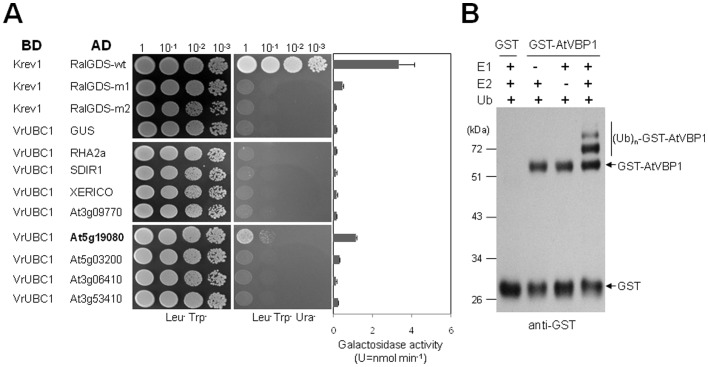
Interaction between E3 ligases and VrUBC1 in yeast and in vitro self-ubiquitination of AtVBP1.(A) Protein interactions of VrUBC1 with five C3HC4-type RING E3 ligases and three positive regulators for osmotic tolerance such as RHA2a, SDIR1 and XERICO were analyzed by Y2H system. For the strong positive interaction control, Krev1 (Rap1A, a member of the Ras family of GTP binding proteins) and RalGDS-wt (the Ral guanine nucleotide dissociator stimulator protein) was used. RalGDS-m1 has weak interaction and RalGDS-m2 has no interaction with Krev1. Yeast MaV203 strains containing the indicated plasmid combinations were grown in SD medium without Leu and Trp to an OD600 of 1.0, and 10 µl aliquots of different dilutions (1, 10−1, 10−2, 10−3) were spotted onto selective and non-selective plates (non-selective medium, SD/−Leu/−Trp; selective medium, SD/−Ura/−Leu/−Trp). The combination of plasmids is indicated on the left and dilution series are indicated at the top. β-galactosidase activity was determined in the MaV203 yeast cells cotransformed with the BD/AD plasmids. Data represent means ± SD from three independent experiments. All the experiments were carried out at least in three replications. (B) Purified GST-AtVBP1 was incubated at 30°C for 2 h with VrUBC1 (E2), yeast E1, Ub, and ATP. Samples were separated by SDS-PAGE, and ubiquitinated proteins were detected by immunoblot analysis using anti-GST antibodies.